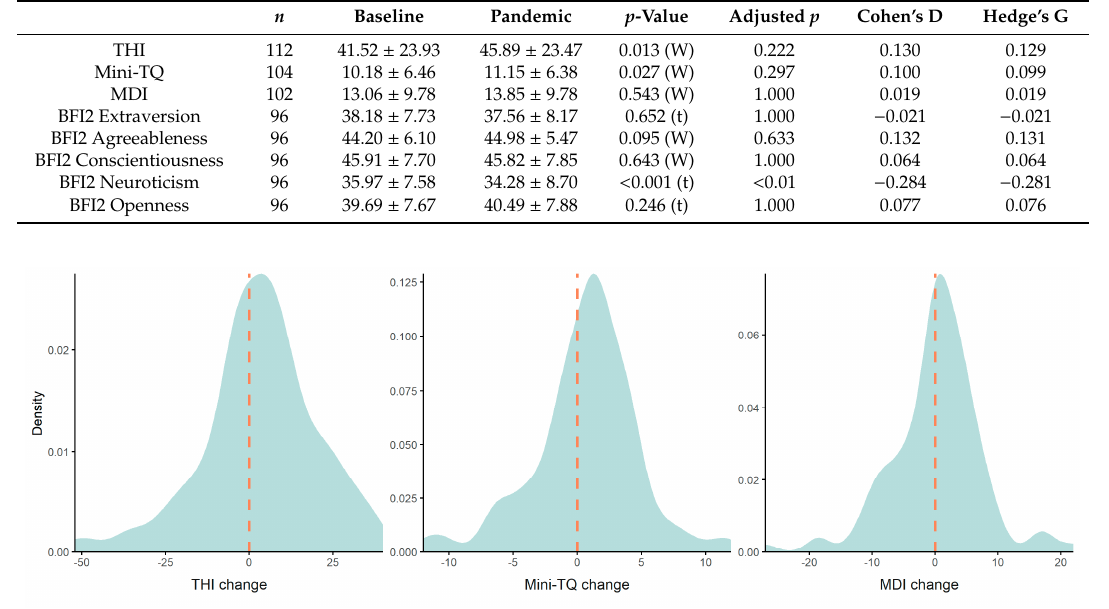
Figure 1. Influence of pandemic situation on tinnitus-related distress and depressive symptoms. The difference (change) was calculated by subtracting time point 2 (pandemic situation) from time point 1 (baseline). Higher values indicate more severe symptoms during the pandemic.